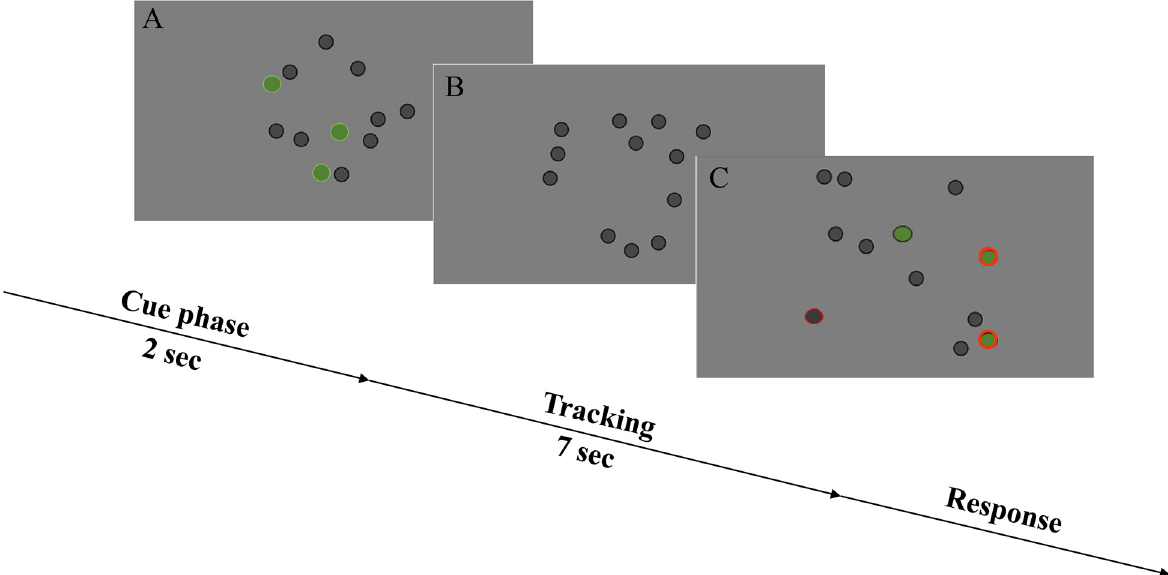
Fig 1. Multiple object tracking task. (A) Cue phase: Target dots, between 1 to 5, are marked in green for 2 seconds to designate them as targets for the tracking task. (B) Tracking phase: target dots turn back to grey. All of the dots, now identical, move around randomly on the display for 7 seconds. (C) Response phase: subjects report the final locations of the target dots and receive feedback on correct and incorrect choices (grey dot with red outline = incorrect selection, green dot with black outline = target dot but not selected, and green dot with red outline = target dot and